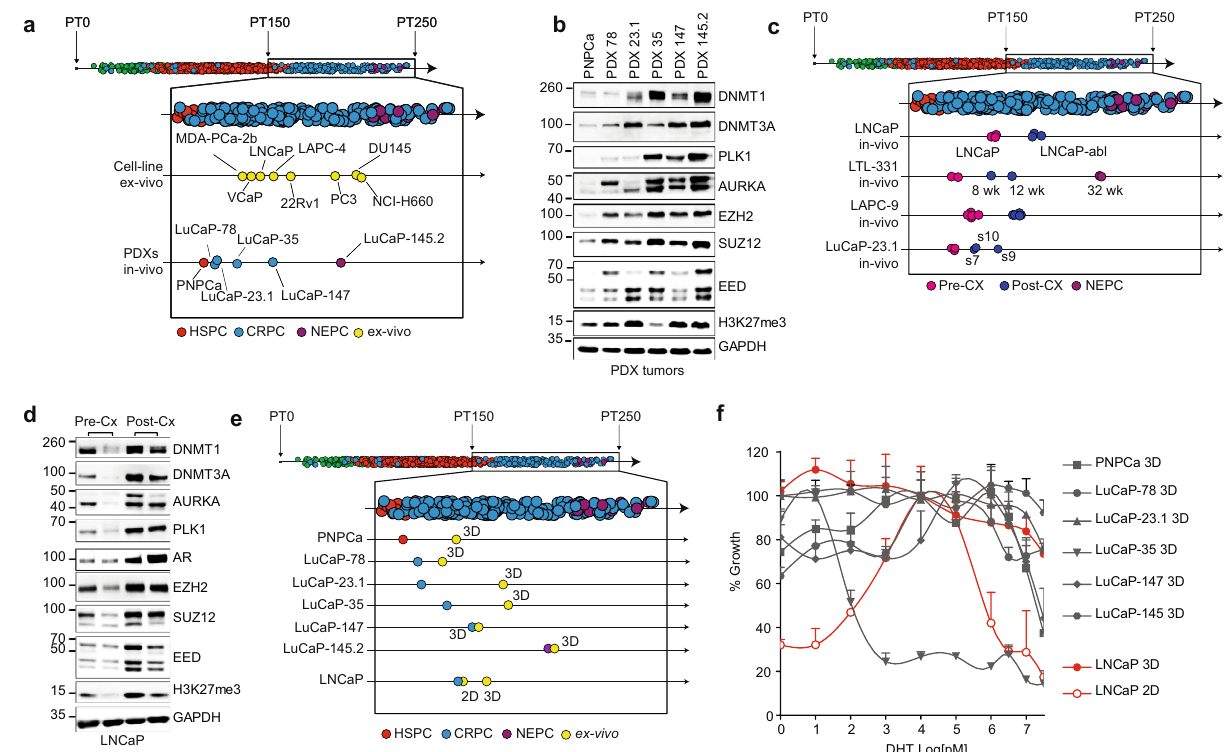
Fig. 2 Mapping of human prostate cancer models to the trajectory. a Projection of the indicated human cell lines ex vivo and patient-derived xenograft (PDX) models in vivo to the pseudotime (PT) inferred trajectory. Normal prostate: green; hormone-sensitive tumors (HSPC): red; castration-resistant (CRPC) tumors: blue; neuroendocrine (NEPC) tumors: violet; ex vivo cell lines: yellow. Representative replicates for each sample are shown. See Source data fi le. b Immunoblotting analysis of the indicated proteins across PDX models indicates an upregulation of polycomb-repressive complex-2 members and G2M cell cycle checkpoint genes. Experiments were repeated at least three times with similar results. See Source data fi le. c Androgen-dependent xenograft models progress along the trajectory when developing castration resistance. Normal prostate: green; hormone-sensitive tumors (HSPC): red; castration-resistant (CRPC) tumors: blue; neuroendocrine (NEPC) tumors: violet; pre-castration (Pre-CX) PDX models: magenta; post castration (Post-CX) PDX models: dark blue; Wk weeks; s7, s9, and s10 indicate different clones derived from LuCaP-23.1 PDX model. See Source data fi le. d Immunoblot analysis of LNCaP xenograft models shows upregulation of AR, polycomb-repressive complex-2 members, and G2M cell cycle checkpoint genes upon recurrence after castration (Cx). Experiments were repeated at least three times with similar results. See Source data fi le. e Three-dimensional (3D) ex vivo cultures in Matrigel of the indicated PDX and the xenografted LNCaP cells show higher PT than their in vivo counterparts. Normal prostate: green; hormone-sensitive tumors (HSPC): red; castration-resistant (CRPC) tumors: blue; neuroendocrine (NEPC) tumors: violet; ex vivo: yellow. Representative replicates for each sample are shown. Individual replicates are depicted in Supplementary Fig. 2. See Source data fi le. f Dihydrotestosterone (DHT) dose – response curves of the indicated models in 3D using Matrigel versus standard 2D culture. In the 3D conditions, DHT dependency is largely abolished. For each curve, n = 3 biologically independent experiments are reported (three animals for each curve). Error bars represent standard errors for each time point. LNCaP: red; PNPCa, LuCaP and PNPCa models: gray. See Source data fi